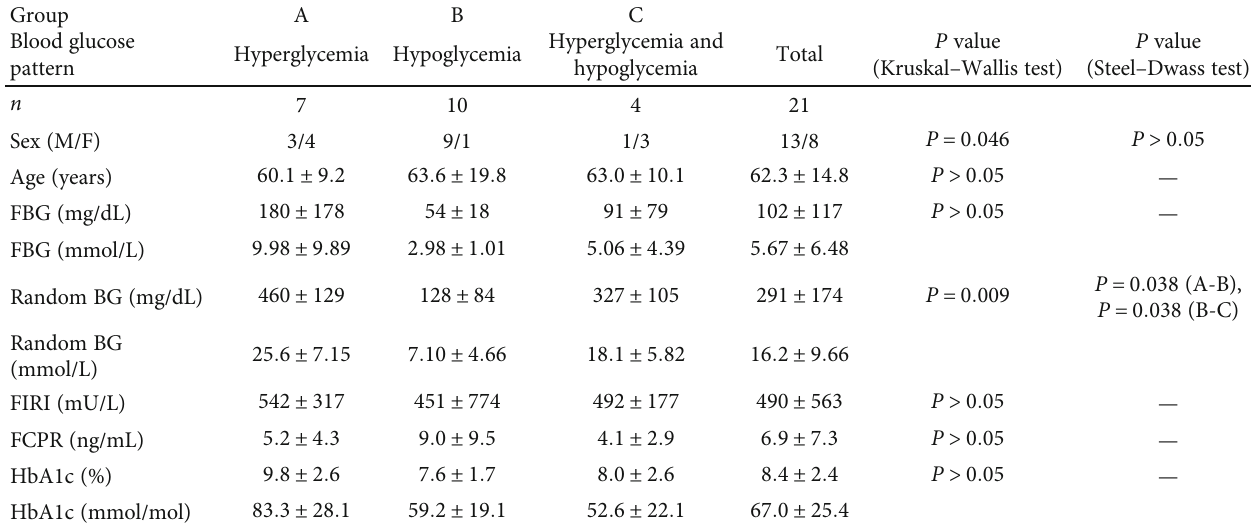
Table 4: Clinical characteristics and biochemistry measurements at baseline.